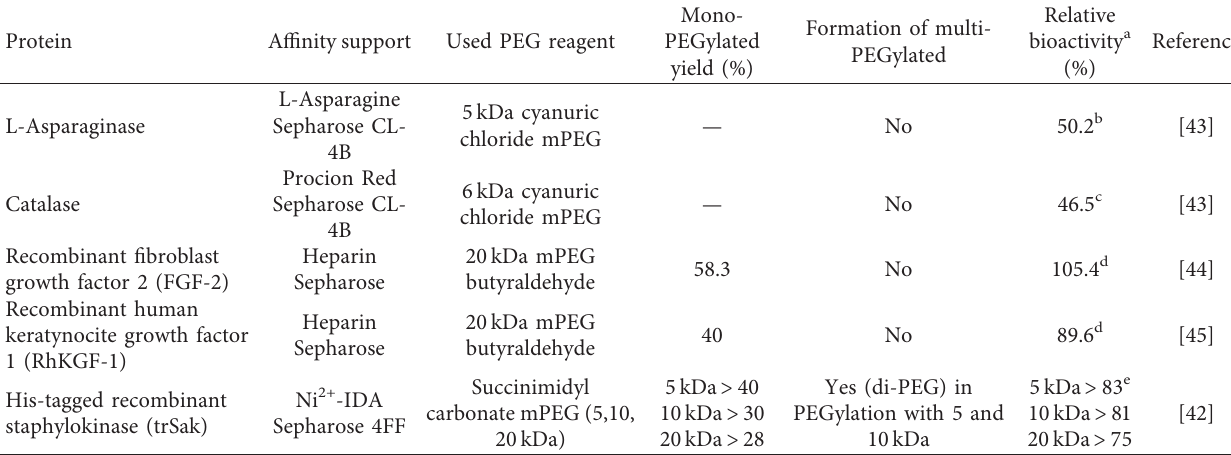
Table 2: Affinity solid-phase PEGylation of some important